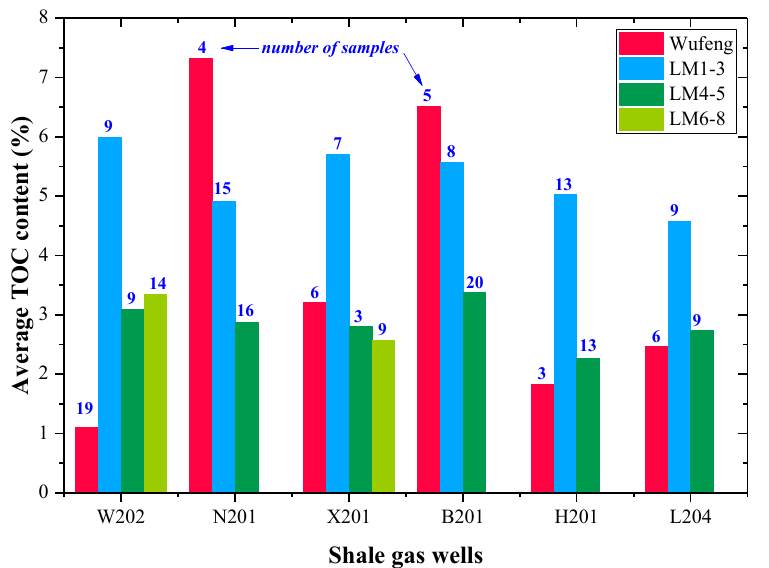
Figure 3. The average TOC contents of shale samples from each substratum in the six shale gas wells.